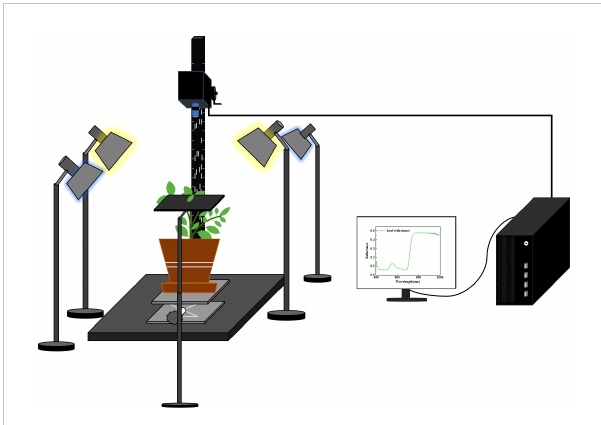
FIGURE 2 HSI system for tomato leaf data acquisition.